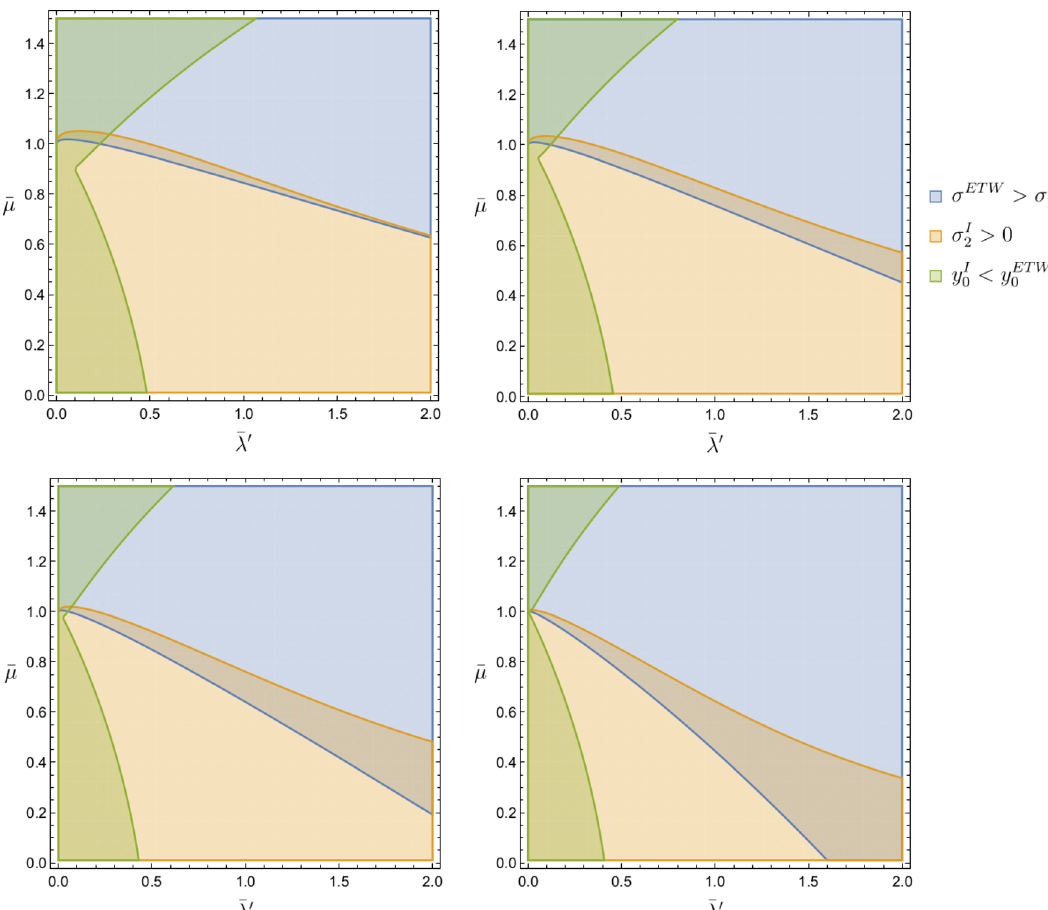
Figure 4 . Plots of the regions in the parameter space (¯ λ 0 , ¯ µ ) with σ ETW > σ I y I < y ETW 0